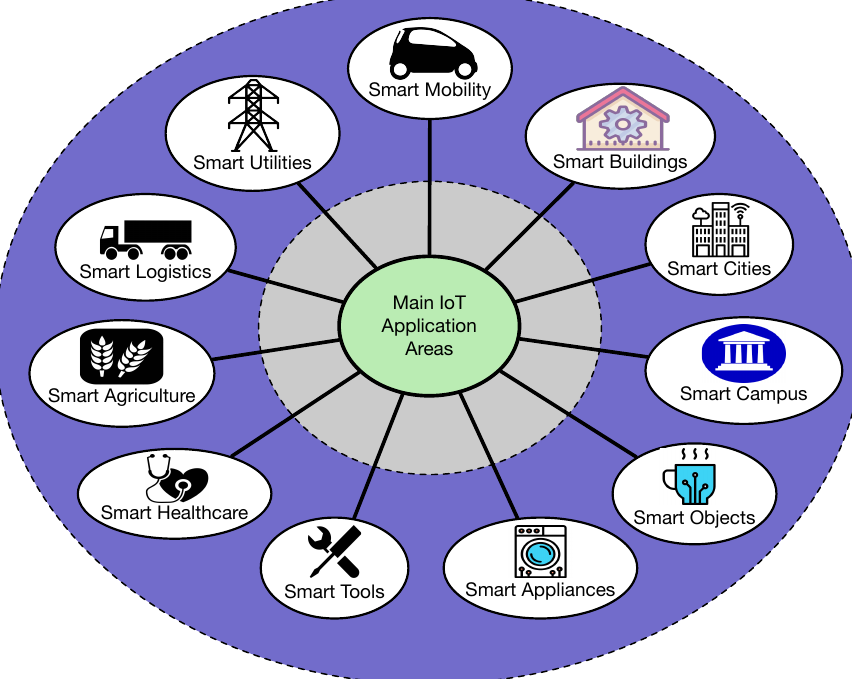
Figure 1. Main Internet of Things (IoT) application